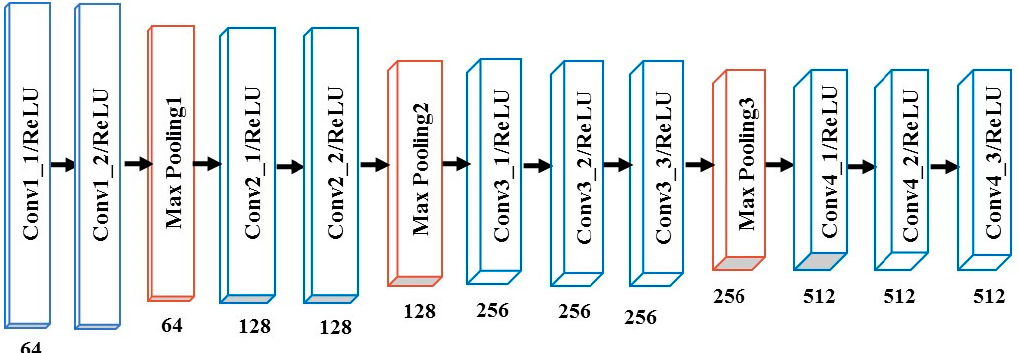
Figure 2. The first four sets of convolutions in the VGG-16 network.